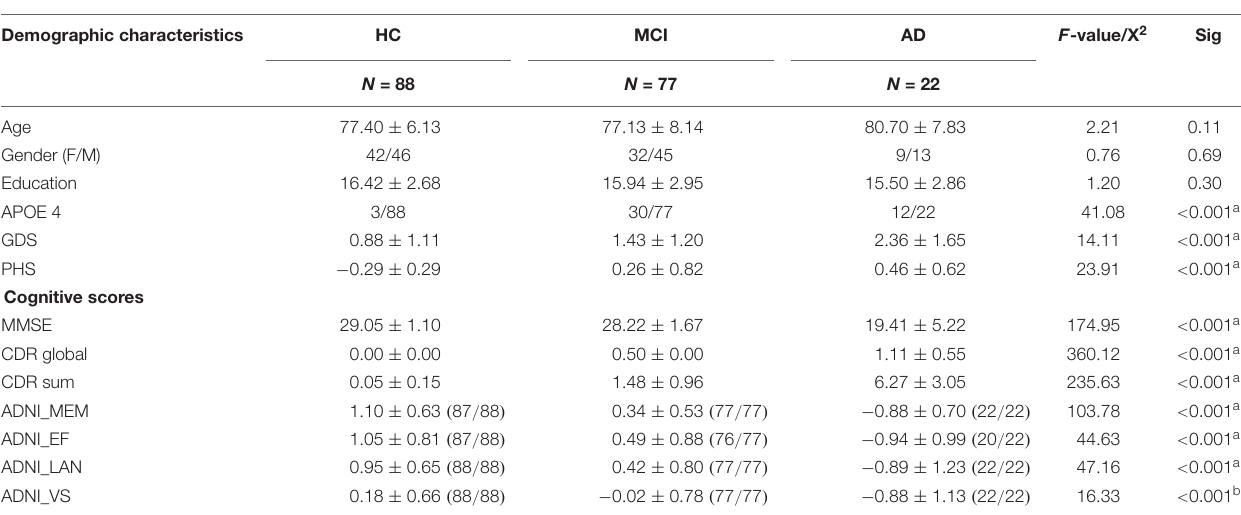
FIGURE 1 | Data analysis flowchart using fusion with reference. Extracted neuroimaging features (fALFF, GMV, and amyloid SUVR) are first stacked to 2D matrices for each modality. Then, PHS is used as the reference to guide the joint decomposition of three features to generate spatial maps (C1,C2,C3) and their corresponding canonical variants (A1,A2,A3) . Finally, joint ICA is applied on the concatenated spatial maps to obtain the final ICs and their corresponding mixing matrices. fMRI, functional MRI; sMRI, structural MRI; HC, healthy control; MCI, mild cognitive impairment; AD, Alzheimer’s disease; fALFF, fractional amplitude of low frequency fluctuations; GMV, gray matter volume; SUVR, standard uptake value ratios; PHS, polygenic hazard score; MCCAR, multisite canonical correlation analysis with reference; ICA, independent component analysis; IC, independent components. TABLE 1 | Demographic